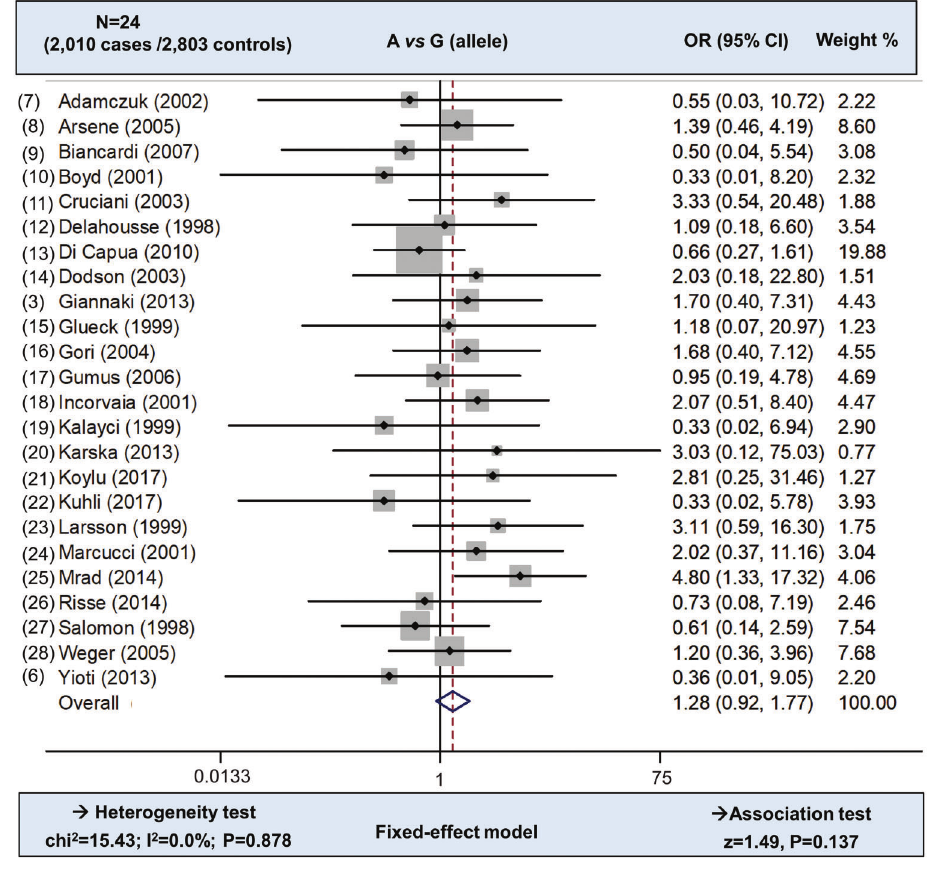
Figure 2. Overall meta-analysis under the A vs G (allele) model. OR: odds ratio; CI: con fi dence internal; N: study